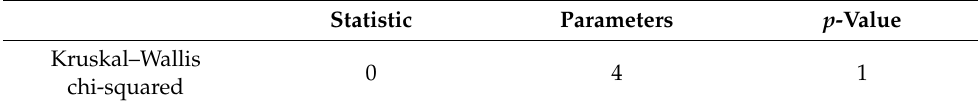
Table 6. Kruskal–Wallis test of the simulated portfolios’ ex-ante Sharpe ratios.